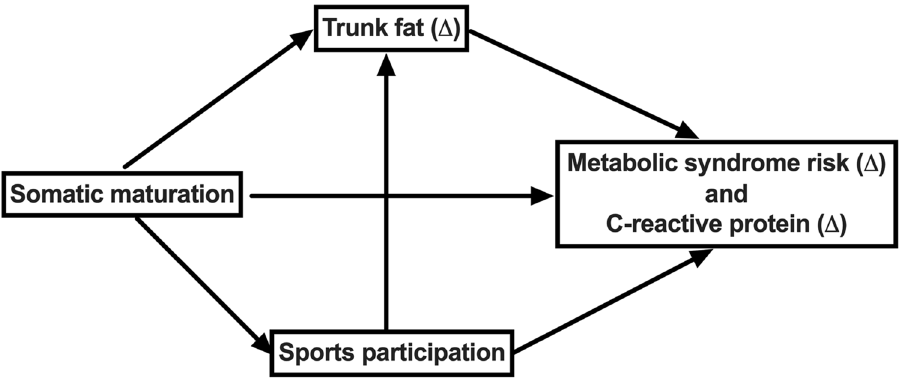
Figure 1. Theoretical model. Δ represents the change from baseline to